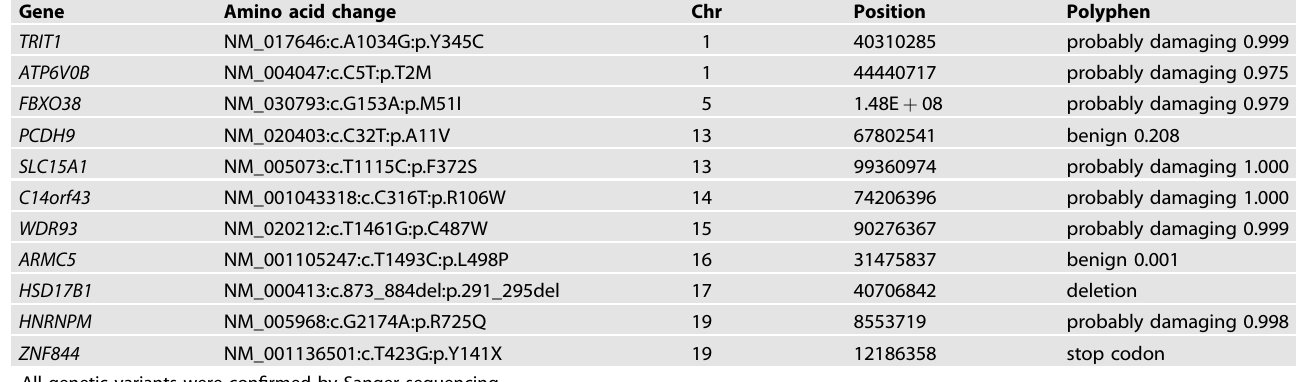
Table 1. Patients'-speci fi c genetic